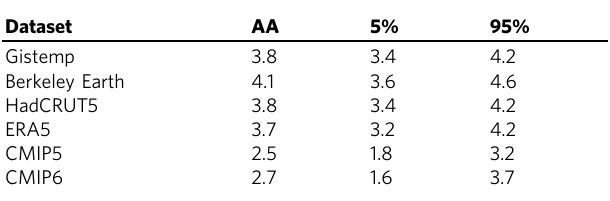
Table 1 Arctic ampli fi cation ratio and its 5th and 95th percentiles calculated for the period 1979 – 2021 from the observational datasets, CMIP5 ensemble, and CMIP6 ensemble.